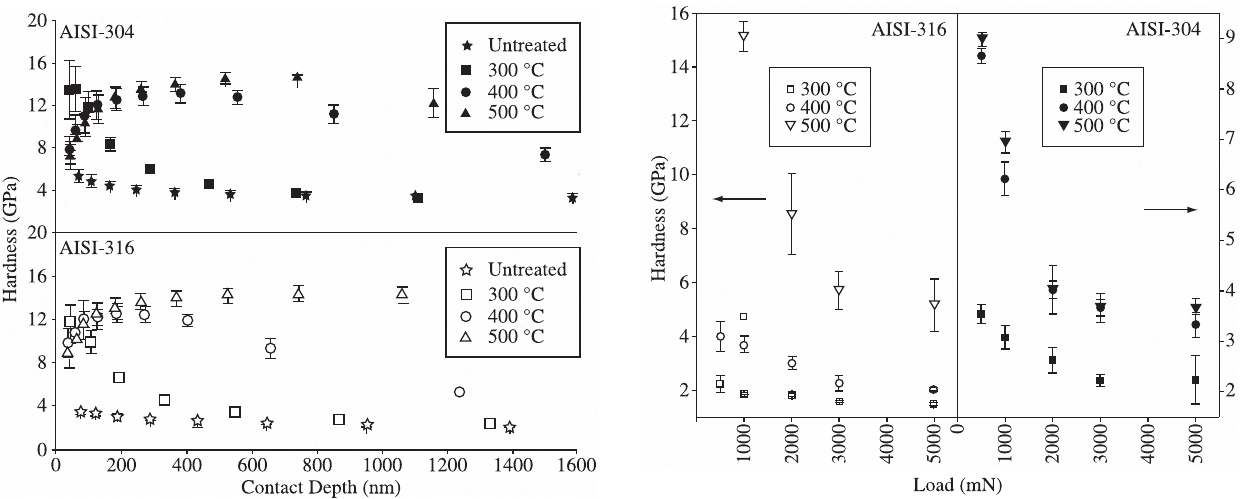
Figure 4. Vickers hardness profiles for AISI 304 and AISI 316 nitrided at differ- ent working temperatures. Note the different hardness scales for the